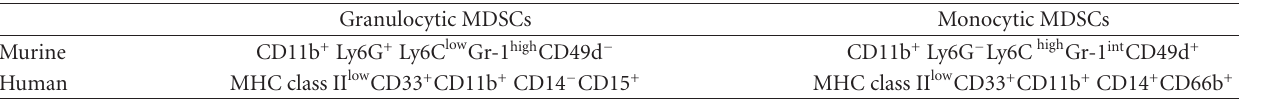
Table 2: Phenotype of monocytic and granulocytic MDSCs subsets in murine and